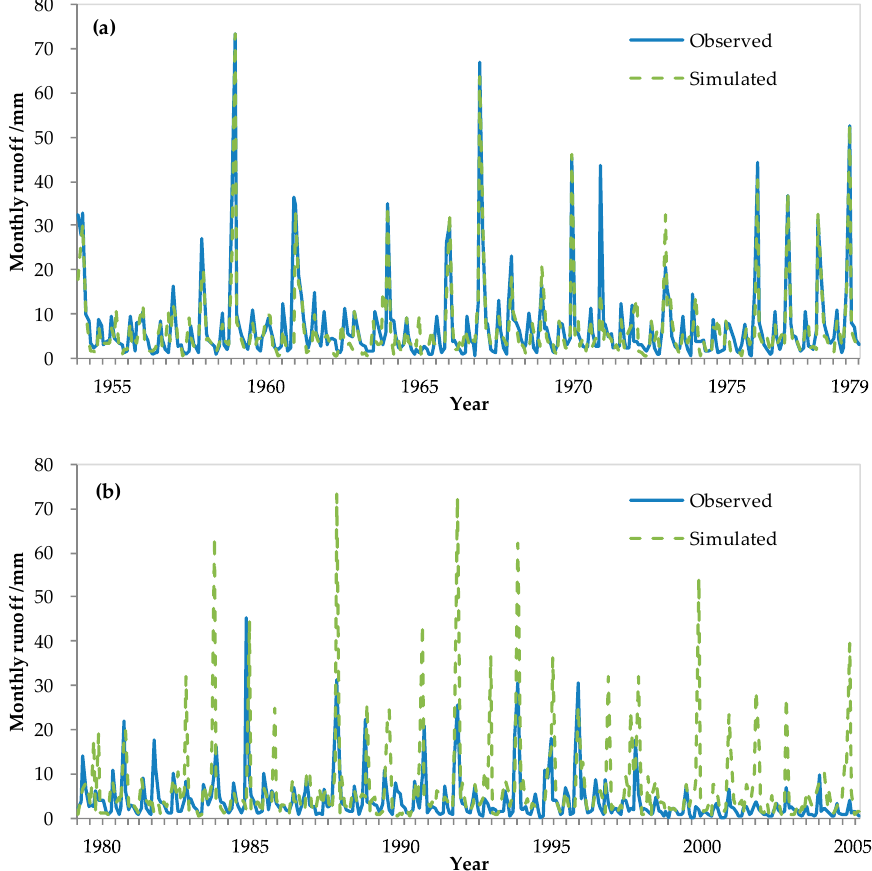
Figure 5. Artificial neural network (ANN) ( a ) simulation results from 1954 to 1979, and ( b ) model prediction results from 1980 to 2005.